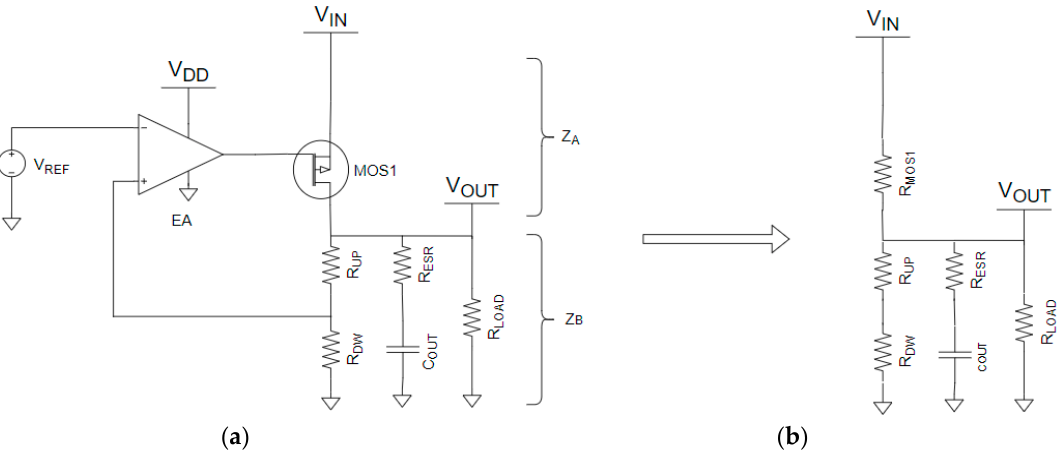
Figure 7. Concept diagram of TPS785-Q1 model: ( a ) general simplified PSRR model concept; ( b ) high frequency PSRR model concept.